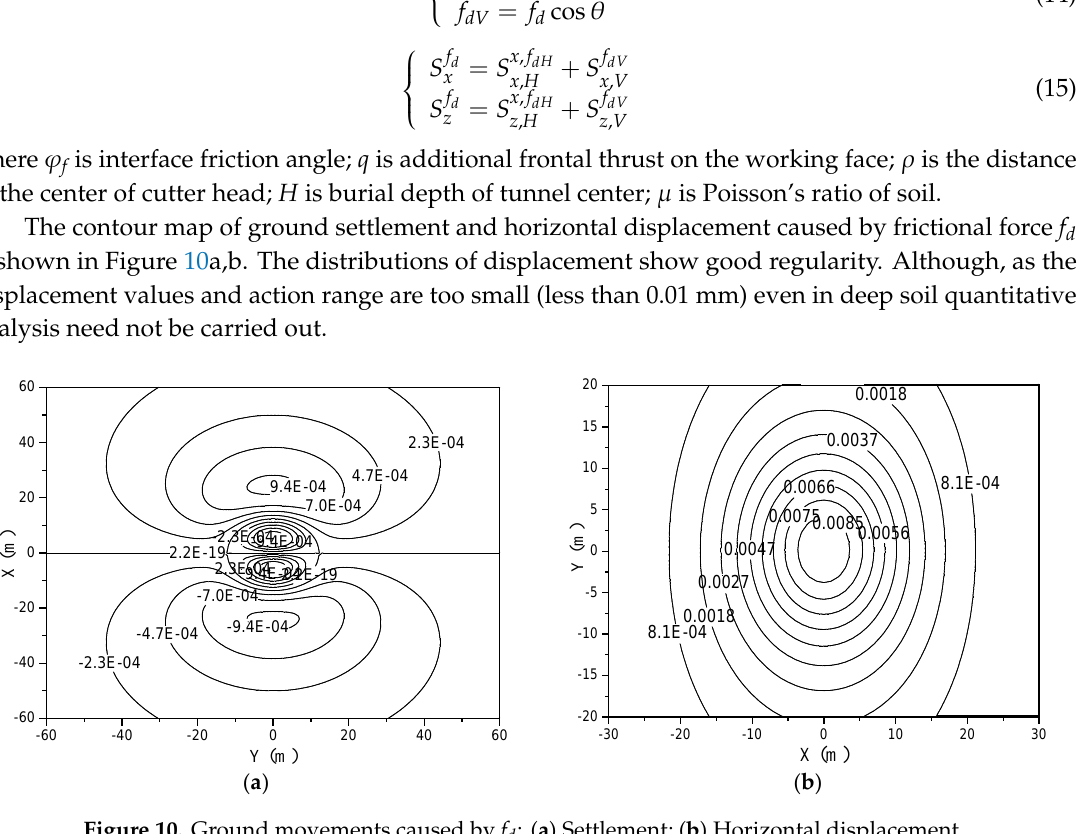
Figure 11. Integral region of f s . 4.4. Quantitative Analysis of Frictional Force f s As the characteristic of shell friction f s between the shield and the soil is like that between pile and soil, slip softening phenomenon should be considered in calculation of f s by Equation (15) [38–